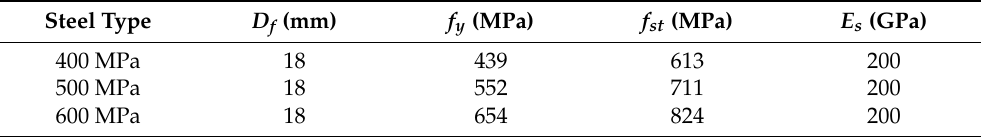
Table 2. Measured mechanical properties of non-prestressed tensile reinforcement.